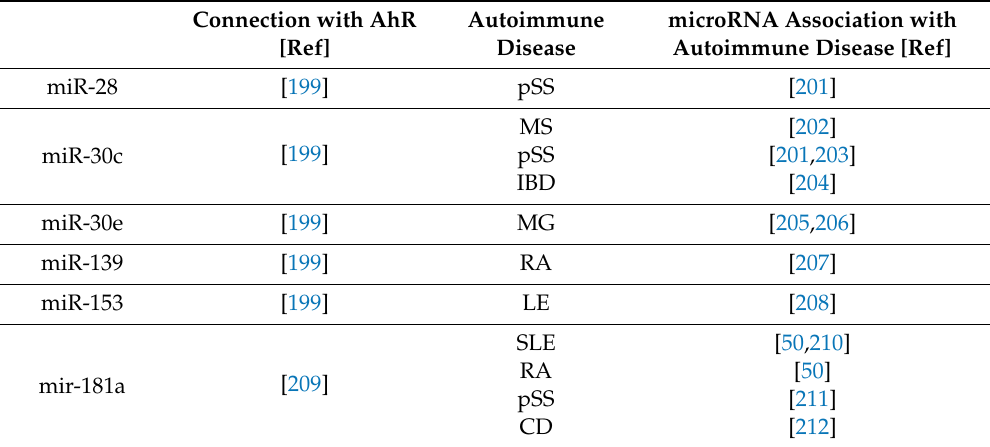
Table 2. microRNA associated with AhR and their impact on selected autoimmune